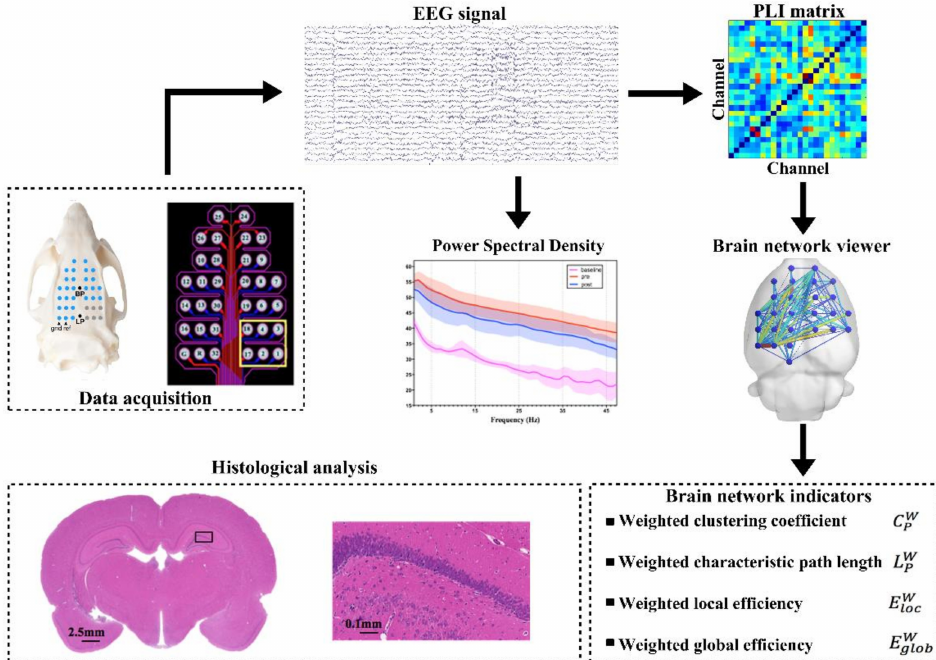
Figure 5. Flowchart for EEG signals processing and weighted functional